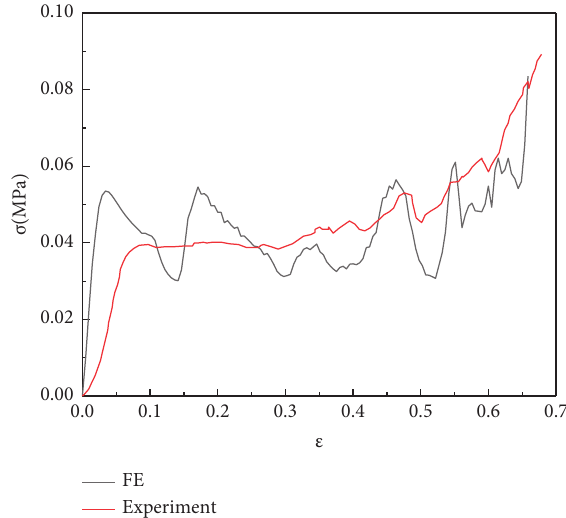
Figure 3: Comparison of the stress obtained from the experiment [35] and the FE analysis.